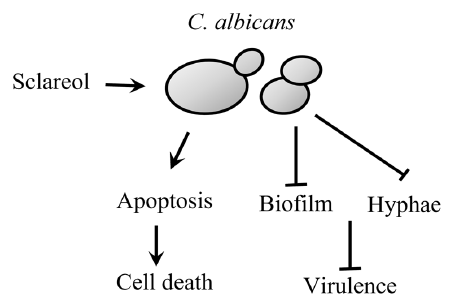
Figure 6. The schematic diagram of anti-fungal effect of sclareol against C. albicans.